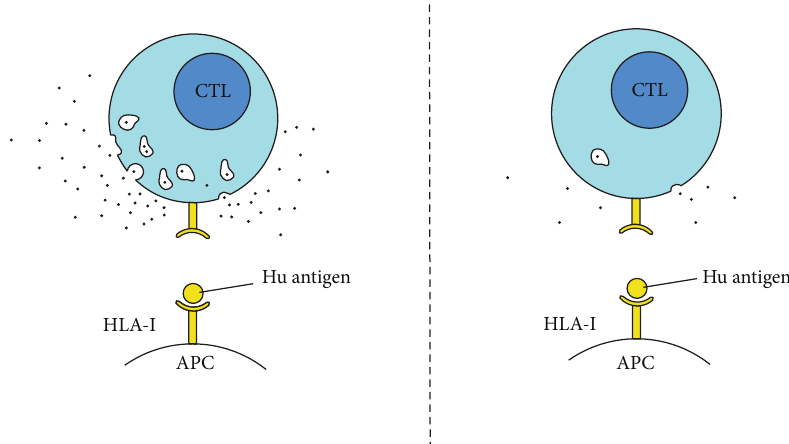
Figure 3: Cytotoxic T lymphocytes that are derived from PNS patients appear to be more aggressive towards cells presenting the Hu